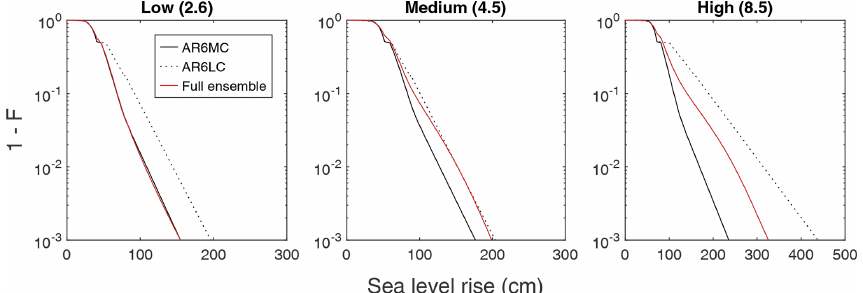
Figure 6. Complementary cumulative distribution functions (1 − F ) of global mean sea level in 2100 relative to 1995–2014 under different emission scenarios. The red line denotes a weighted combination of 10 sea level rise projections, including the two IPCC AR6 projections, medium and low confidence (AR6MC and AR6LC, respectively). AR6MC and AR6LC are plotted separately for comparison.